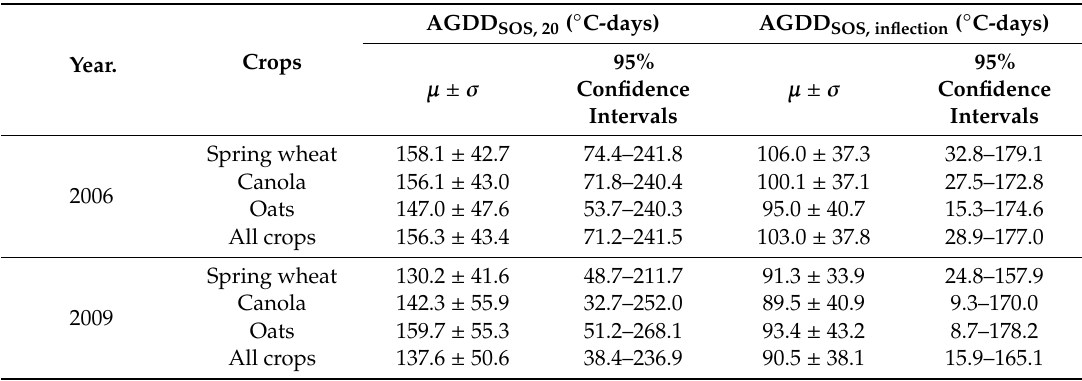
Figure 5. Histogram of AGDD from seeding date to the remotely sensed SOS using the inflection-based (SOS inflection ) and the threshold-based method (SOS 20 ) for spring wheat ( a , d ), canola ( b , e ), and oats ( c , f ) in 2006 and 2009, respectively. Table 3. Summary of the distribution of accumulative growing degree days (AGDD) from observed seeding date to remotely sensed SOS (AGDD SOS ) for di ff erent crops and years; µ and σ are the average value and the standard deviation value of AGDD SOS ,